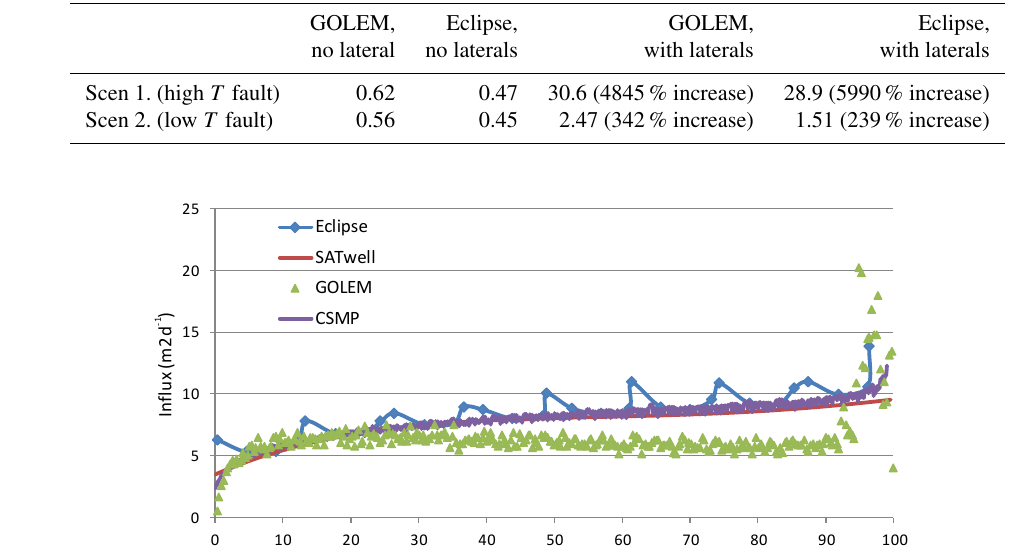
compressibility 10 − 6 1 / MPa and the gravitational accelera- tion is set to